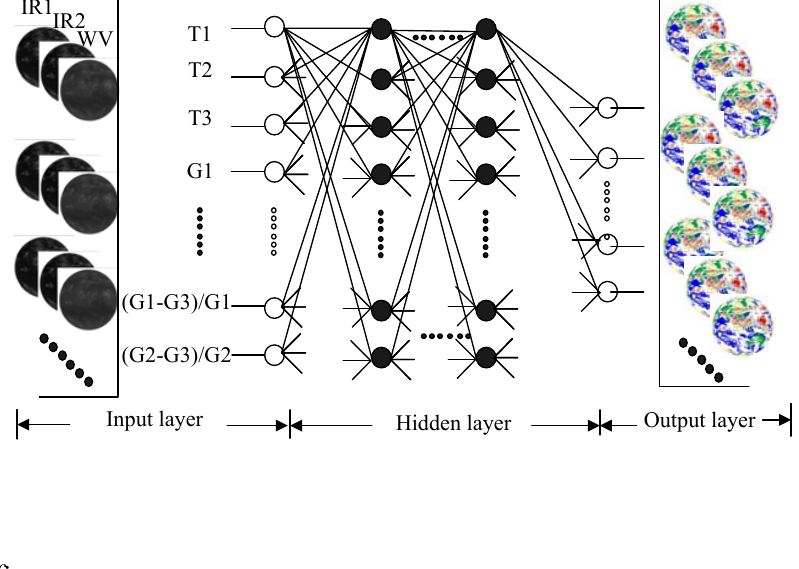
Figure 2. Configuration for the cloud classification: on the lefts are the input satellite images; at the middle are features extracted by GLCM and configuration of classifier; and on the rights are the output cloud classification results. Note white circles on the left are input neurons, and in the right are output ones. Black circles are neurons in hidden layer. Lines around circles show the data